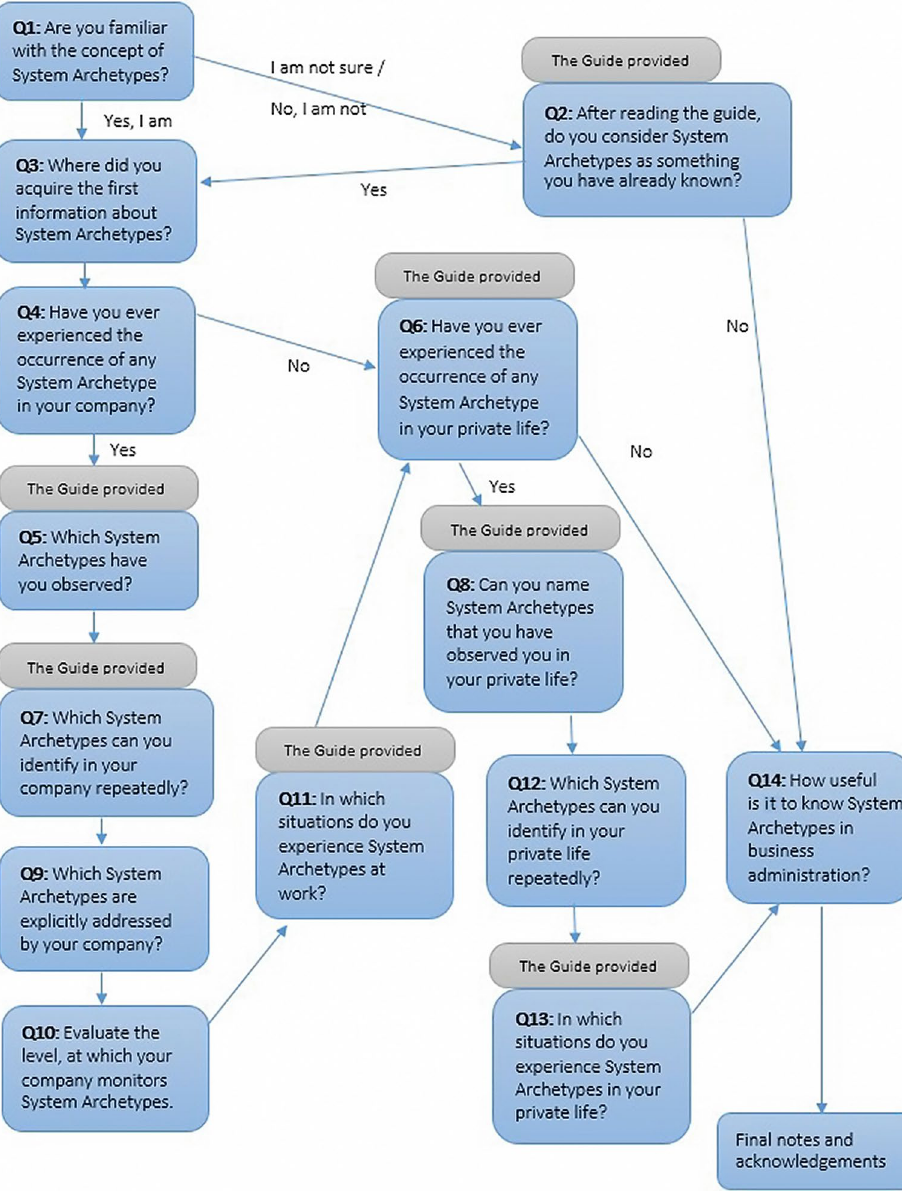
Fig. 1. The flow chart of